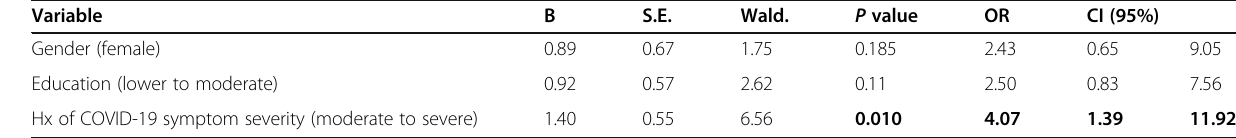
Bold text indicates statistical significance where 95% confidence intervals do not include the null value